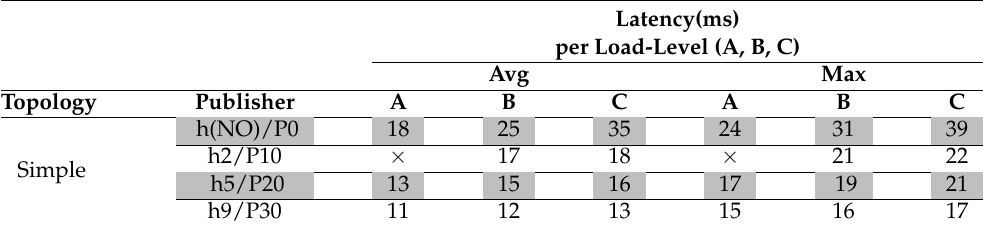
Table 5. Average/Maximum latency of TS and NO MQTT flows with real-time extensions in the physical